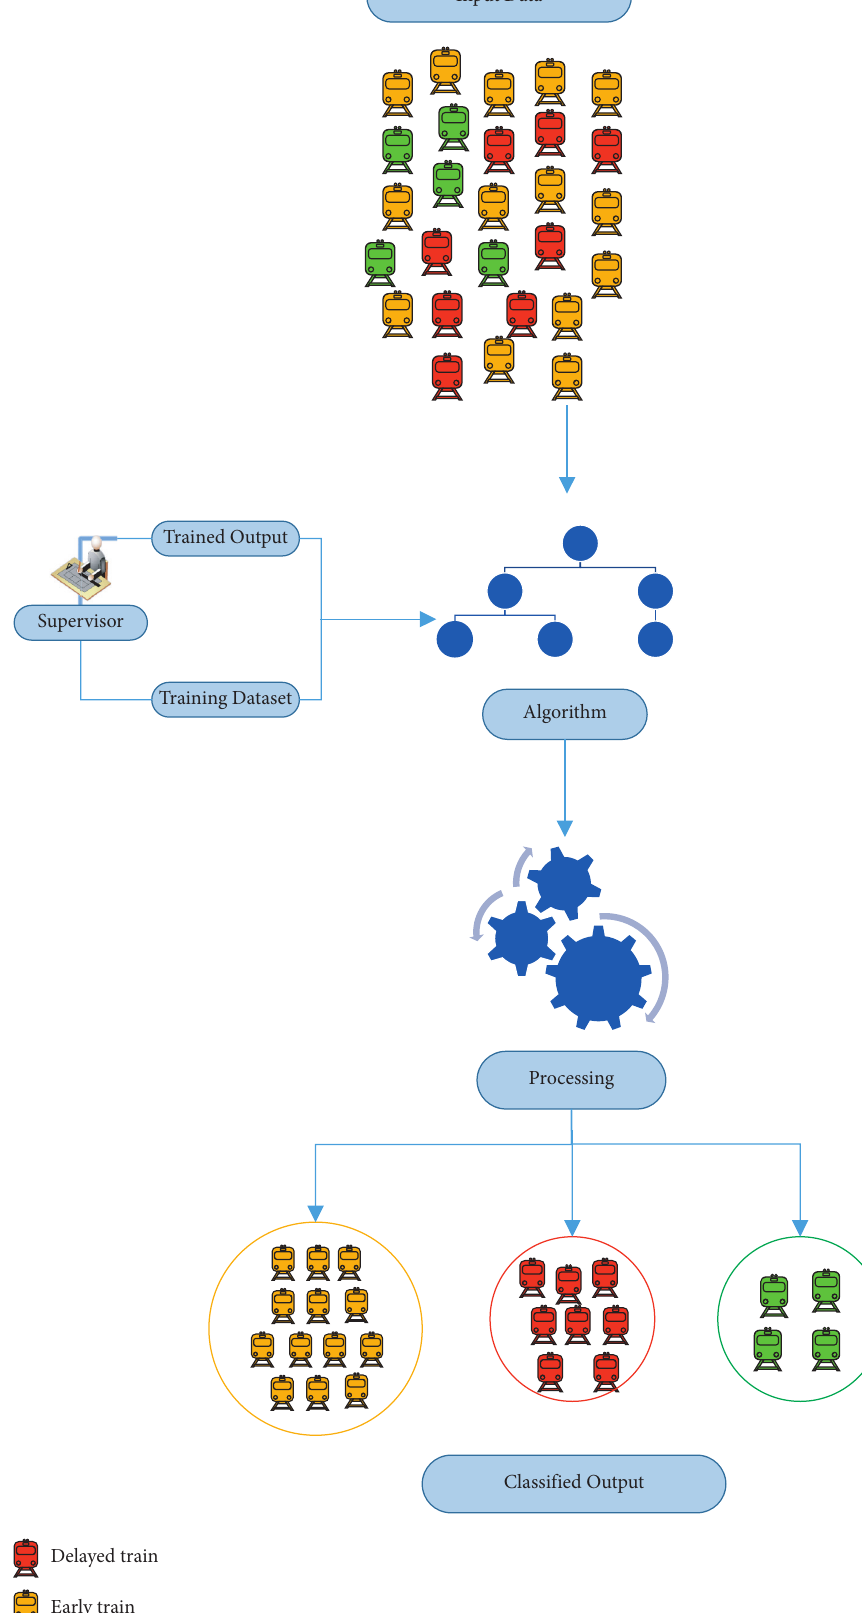
Figure 4: Method (modified from